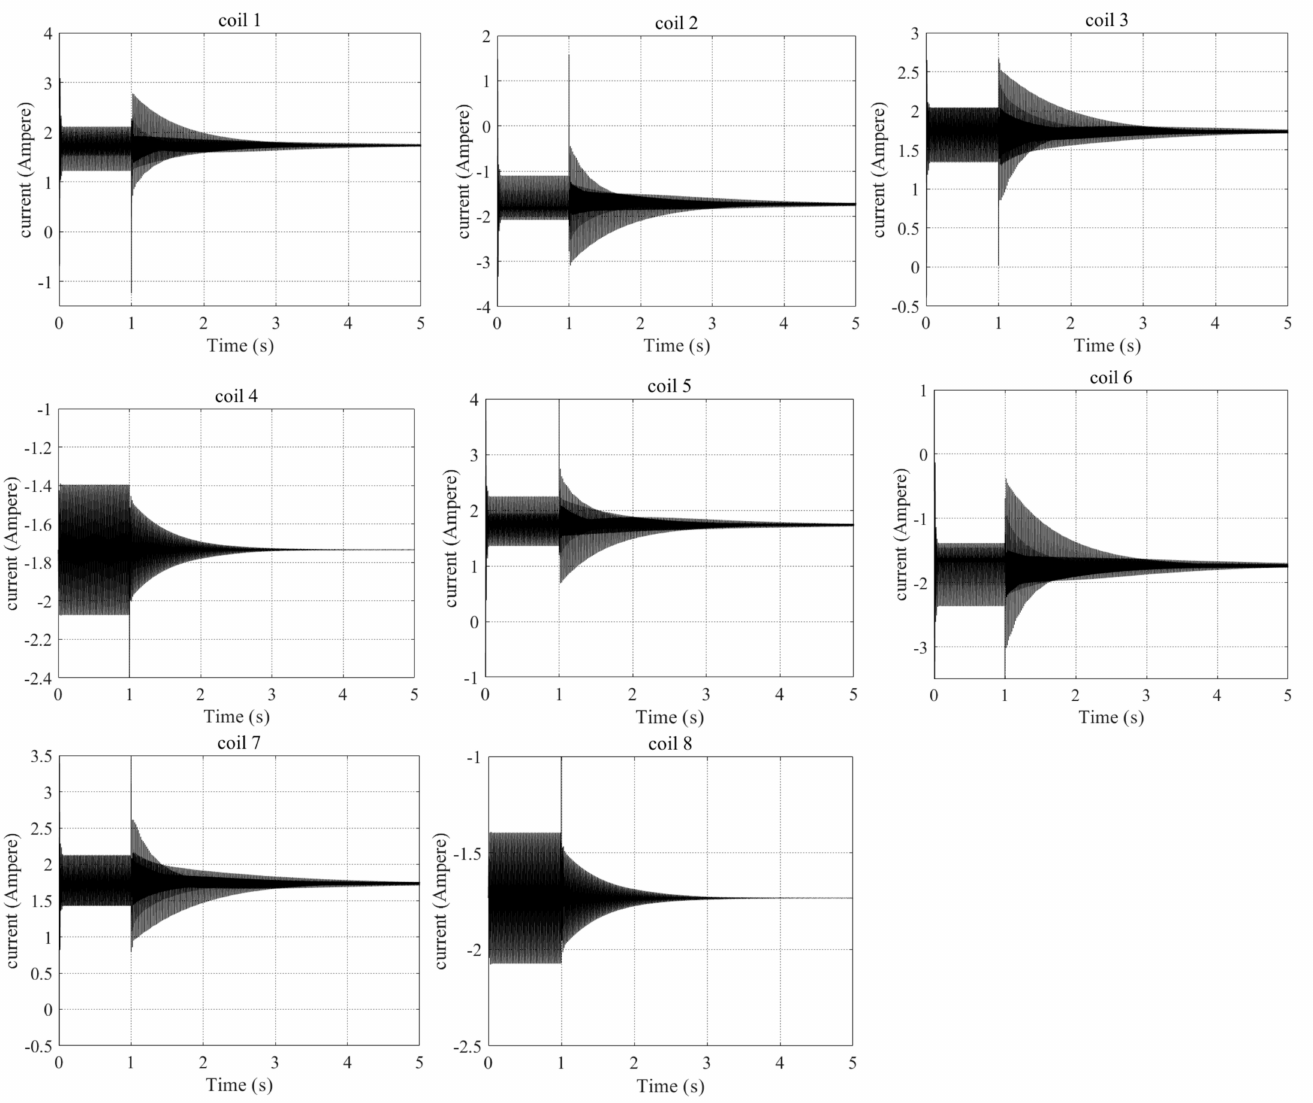
Figure 16. Transient response of current in each coil with the proposed control